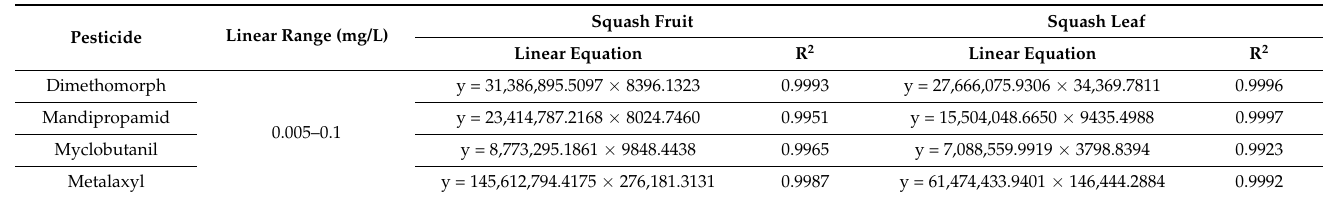
Table 2. Linear equation of the calibration curves for the quantification of the four pesticide residues in squash fruit and leaf.